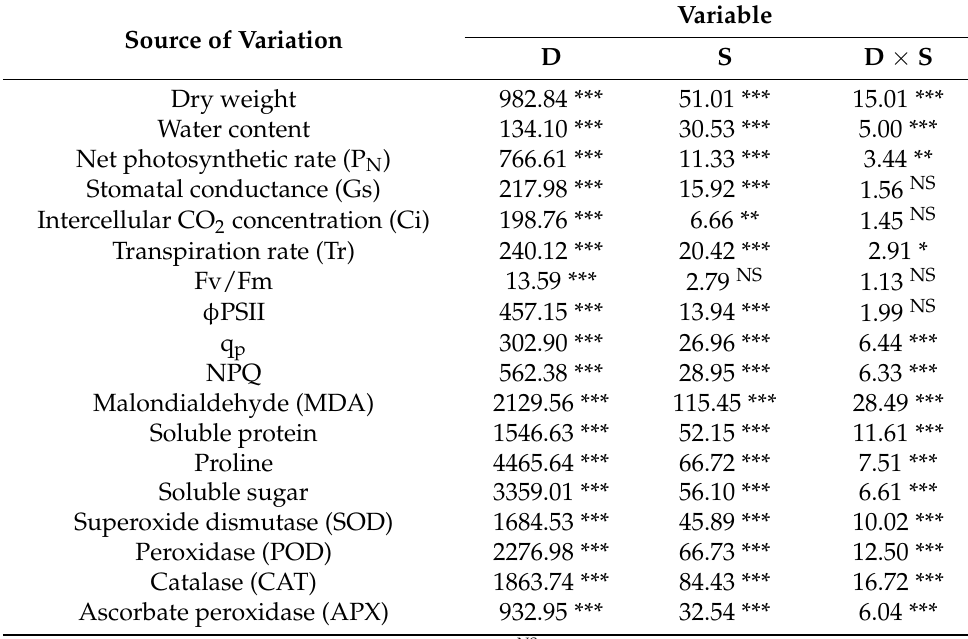
Figure 1. ( A ) Dry weight (DW) and ( B ) water content (WC) of Hordeum jubatum shoots not Spd treated (S0) or pretreated with 0.5 mM Spd (S1), 1.0 mM Spd (S2), and 1.5 mM Spd (S3) under drought stress. Days 0, 5, 10, and 15 correspond to CK, D1, D2, and D3 in the experimental treatment, respectively. The capital letters denote significant differences among the different drought intensities from the shoots under the same concentrations of Spd. The small letters denote significant differences among the different concentrations of Spd from the shoots under the same drought intensity. The differences in each parameter were tested by a one − way analysis of variance (ANOVA) at the p < 0.05 level. The bars represent the means ± SEs (n = 3). Table 1. Two-way analysis of variance (ANOVA) of the effects of drought (D), Spd pretreatment (S), and their interactions on the growth, photosynthesis, chlorophyll fluorescence, lipid peroxidation, osmolyte accumulation, and antioxidant enzymes of Hordeum jubatum